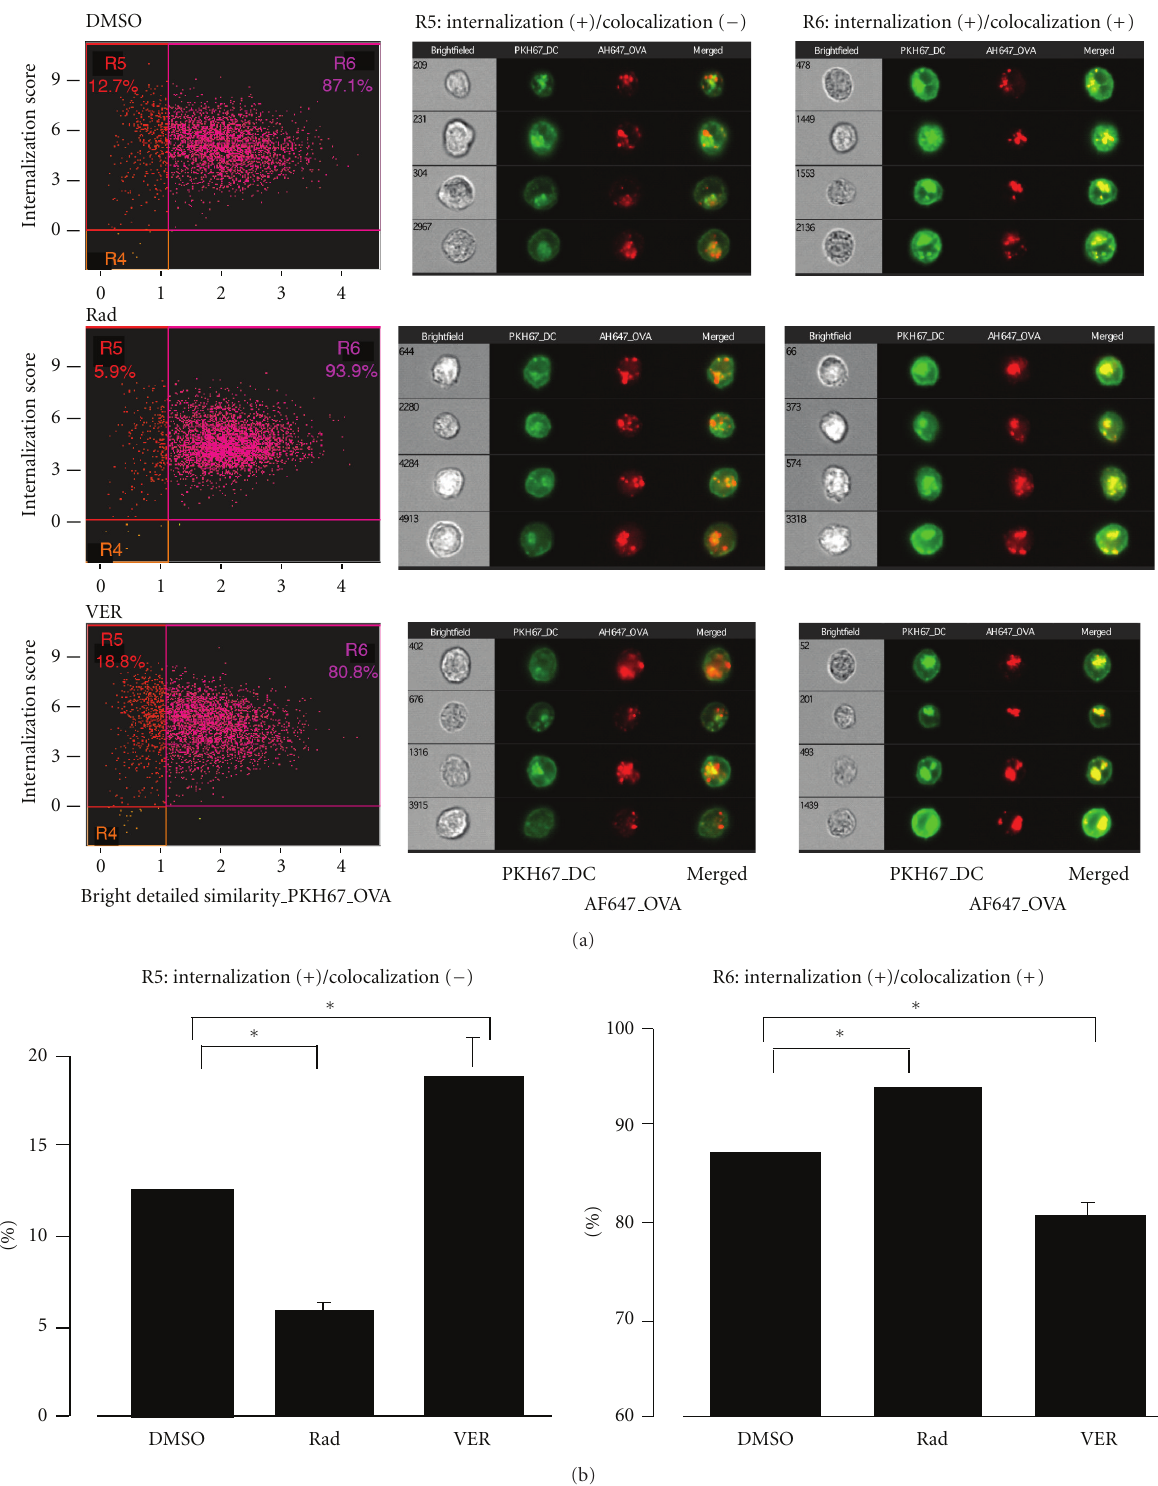
Figure 6: HSP70 inhibitor does not block translocation of OVA to the cytosol following internalization. (a) 0.5mg/mL AF647-labeled OVA was pulsed onto PKH67-labeled DC2.4cells for 5 minutes, washed and subjected to ImageStream analysis. DC2.4 cells were treated with the indicated inhibitors (10 μ M) 15minutes prior to and during the five-minute incubation with OVA. The cells were washed and subjected to ImageStream analysis. (b) Data in (a) were plotted as bar graph. Percentage of DC2.4 cells treated with the indicated inhibitors in R5 and R6 are shown. Data are mean ± SD of two separate experiments. ∗ P < 0 .